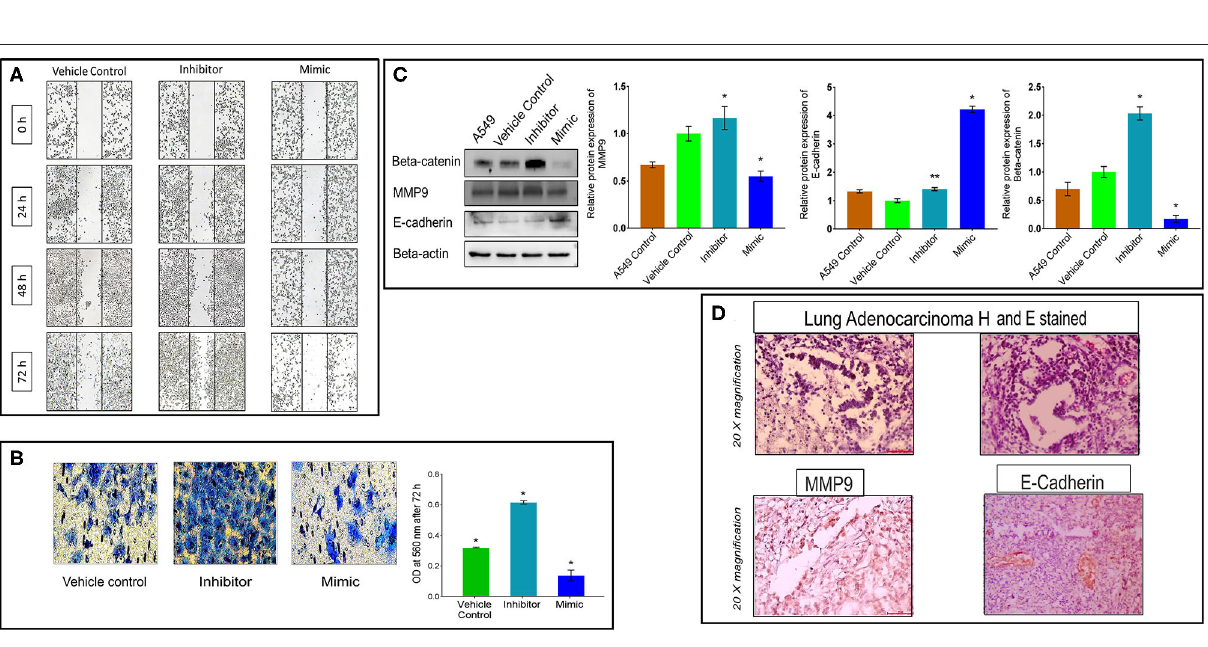
Frontiers in Oncology |